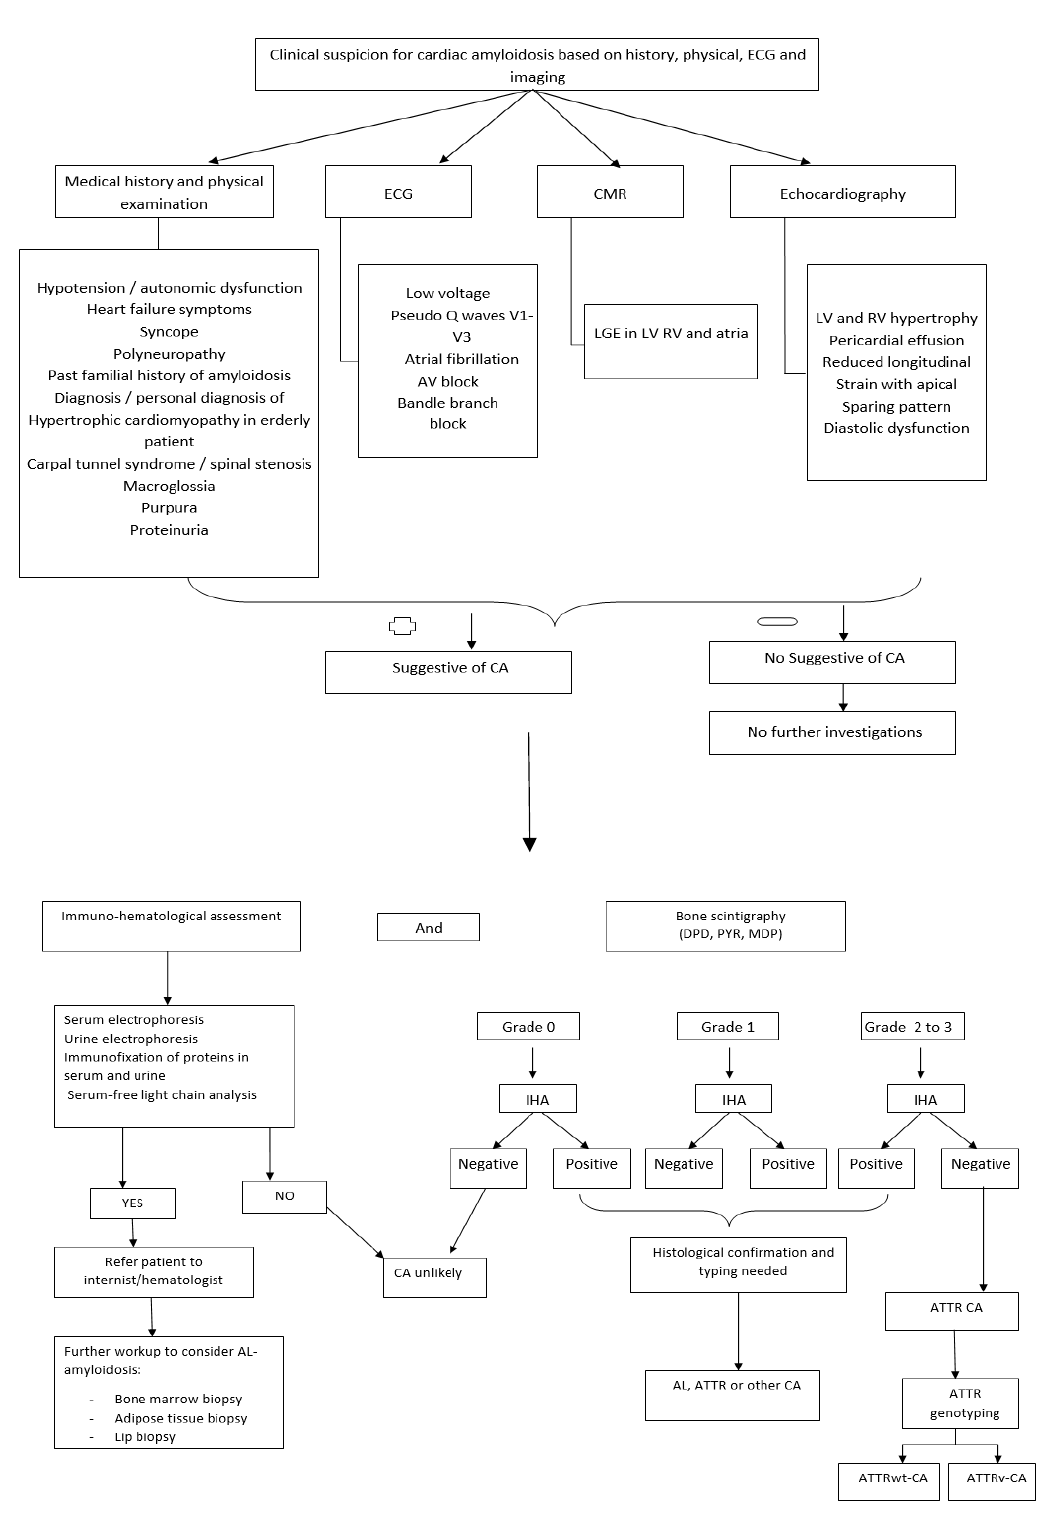
Figure 3. Diagnostic algorithmic approach to the diagnosis of cardiac amyloidosis. CA: cardiac amyloidosis; ECG: electrocardiography; CMR: cardiovascular magnetic resonance; AV: artrioventricular; IHA: Immuno hematological assessment; LGE: late gadolinium enhacement; DPD: propanodicarbdicarboxylic acid; PYR: pyrophosphate; MDP: methylenediphosphonic acid; LV: left ventricular; RV: right ventricular; AL: light chain amyloidosis; ATTR: transthyretin cardiac amyloidosis; ATTRwt-CA: wild-type transthyretin cardiac amyloidosis; ATTRv-CA: variant transthyretin-related cardiac